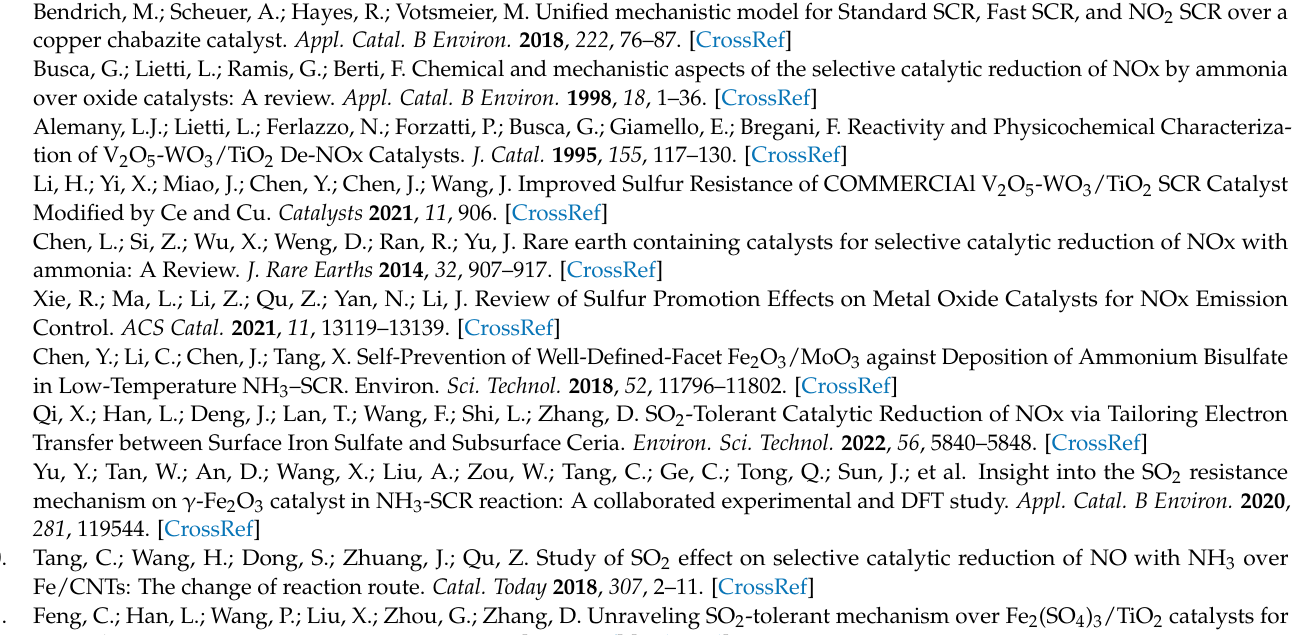
Figure S2. The (a) N 2 adsorption and desorption isotherm (b) and PSD curve of SiO 2 ; Figure S3. NO oxidation of FeO 3 /SiO 2 and Fe 2 O 3 /SBA-15 after